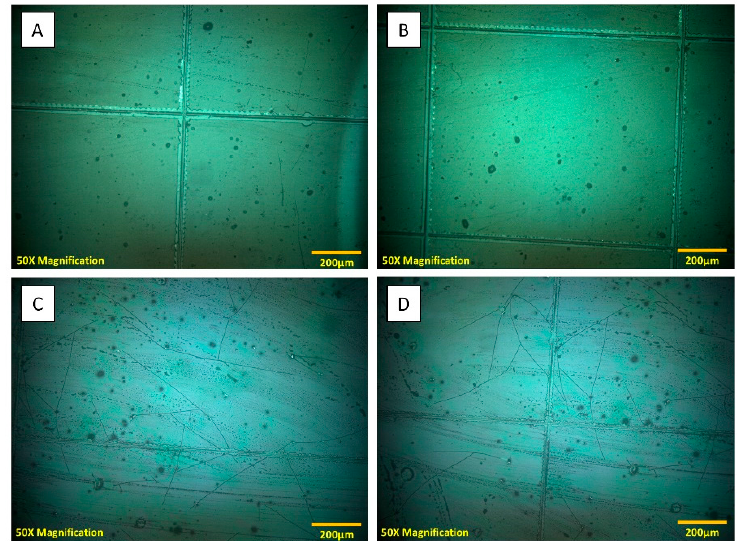
Figure 10. Microscopic examination of coatings in cross-hatch tests of adhesion. ( A , B ) Coating (60% ChSi) surfaces were unblemished by full-depth incisions in the standardized cross-hatch adhesion protocol; ( C , D ) inorganic siloxane material (control) developed extensive arrays of surface cracks and fissures from the same cross-hatch testing protocol. Adhesion of the 60% ChSi coating blend was representative and consistent across all hybrid coatings.